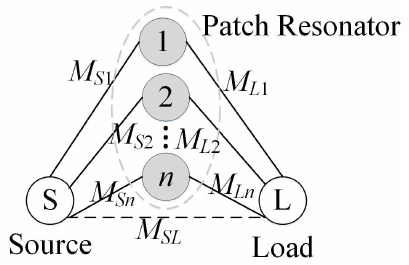
Figure 10. Transversal coupling topology of the proposed filter. A quad-mode BPF employing the TM010, TM110, TM210, and TM310 modes with